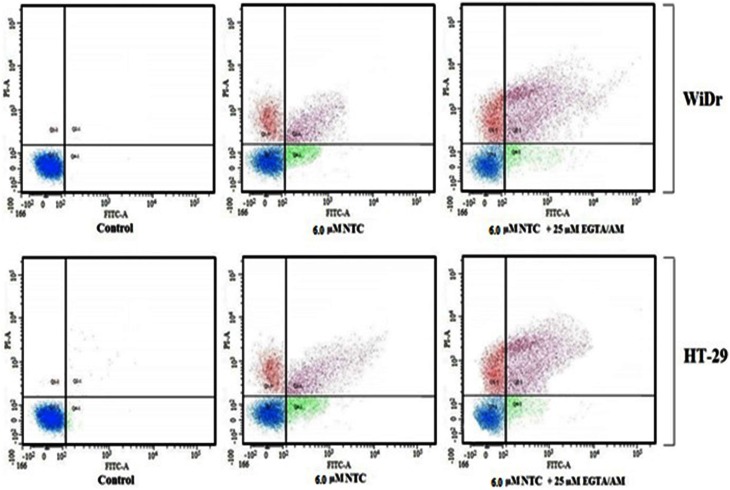
Quality assay of apoptosis. Cells were treated with EGTA/AM (25 μM) prior to exposure to NTC 6.0 μM. Apoptosis analysis shows (Left to right); the untreated cells as the control; 24 h NTC-treatment of the cells; 24 h NTC-treatment+ EGTA/AM.